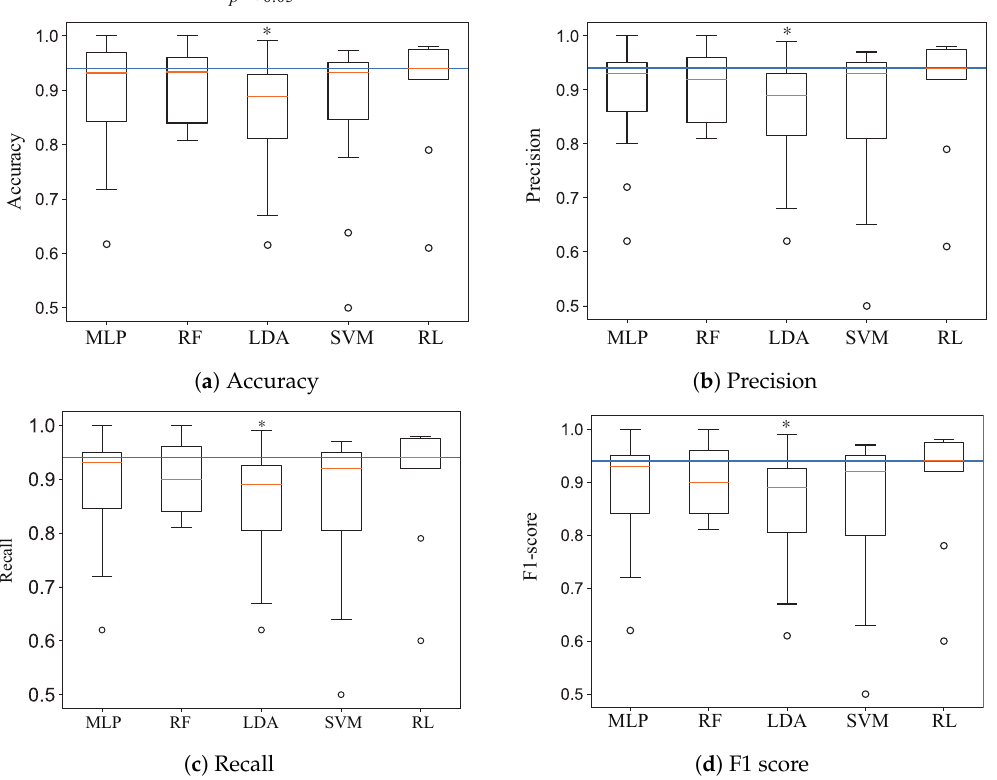
Figure 6. Boxplots of the accuracy, precision, recall, and F1 score based on the classification results of the 11-subject